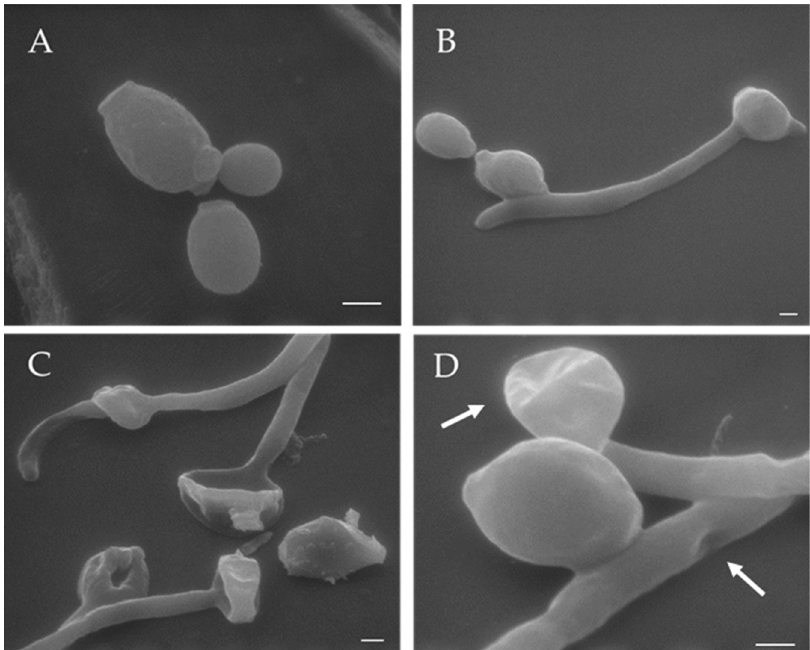
Figure 6. Scanning electron microscopy of Candida albicans cells untreated (control, panels A and B ) or treated with peptide K13L (panels C and D ). Gross alterations in cell morphology were observed after treatment with the peptide (panel C and panel D , arrows). Bar: 1 µm.